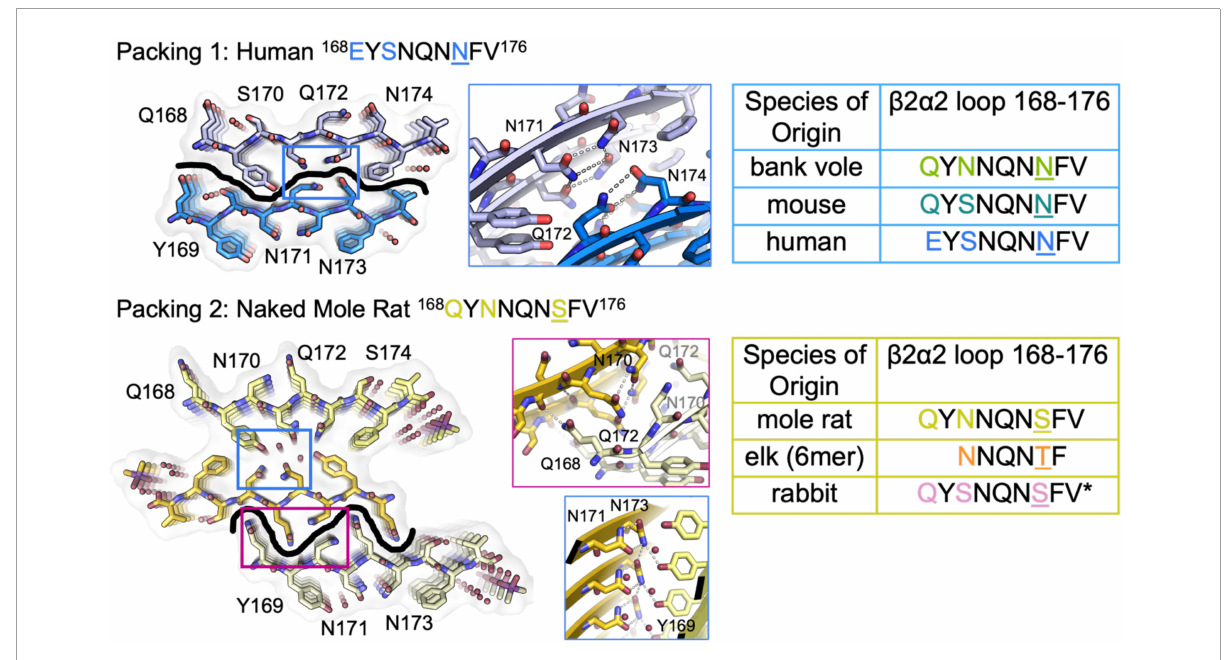
FIGURE3 β 2 α 2 Loop Structures Fall Into Two Structural Categories. Packing arrangement for mouse, human, and bank vole (top) and mole rat, elk, and rabbit (bottom) β 2 α 2 loops with black line highlighting the promiscuous (top) and selective (bottom) interfaces formed in each packing category. Insets show a conserved hydrogen bonding network across species between N171 and N173 (center column, blue boxes). For bank vole, mouse, and human loops (top) N172 and N174 form a clasp (center column, top blue box) while elk and naked mole rat structures (bottom) form a clasp between N170 and N172 (center column, center pink box), leaving Q168 free to form a polar ladder that can interdigitate with a complementary mated sheet. Residues that vary between species are colored in text and residue 174 is shown in color and underlined. Bound waters and ligands shown adjacent to their nearest peptide